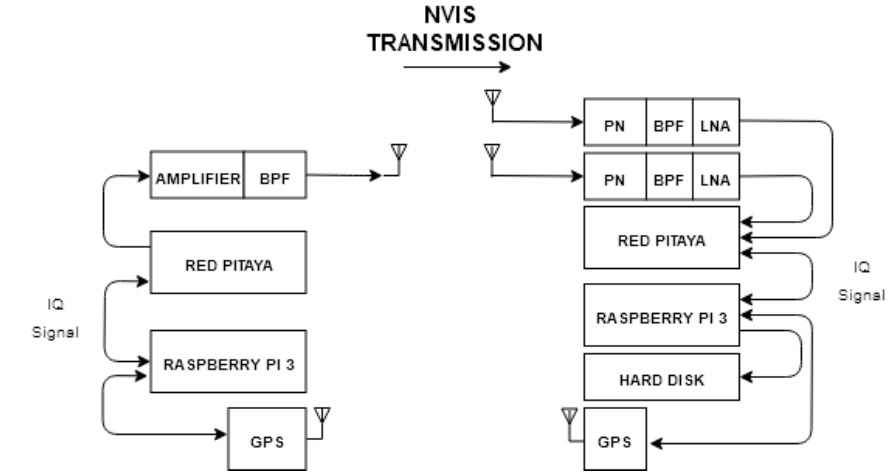
Figure 1. Near-vertical incidence skywave (NVIS) transmission scheme (transmitter in the left and receiver in the right) .